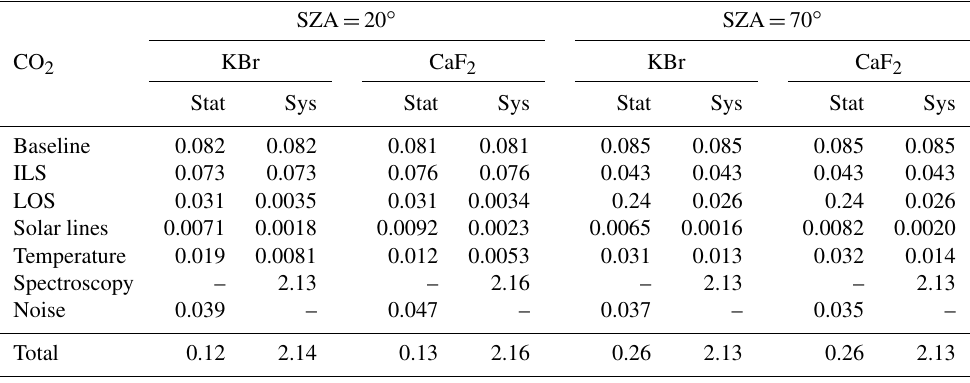
Table 3. Mean ensemble values of the statistical (Stat) and systematic (Sys) errors for 20 and 70 ◦ SZA (given in %) in CO 2 columns due to the assumed error sources of Table 2.